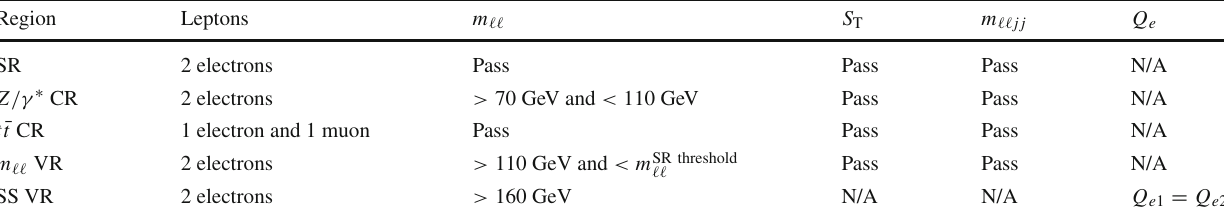
Table 6 Selection requirements applied in addition to the preselection (Table 2) in the CRs, VRs, and SRs for the eejj channel. “Pass”, ‘fail” or “N/A” mean that the requirement is passed, failed or not applied, respectively Region